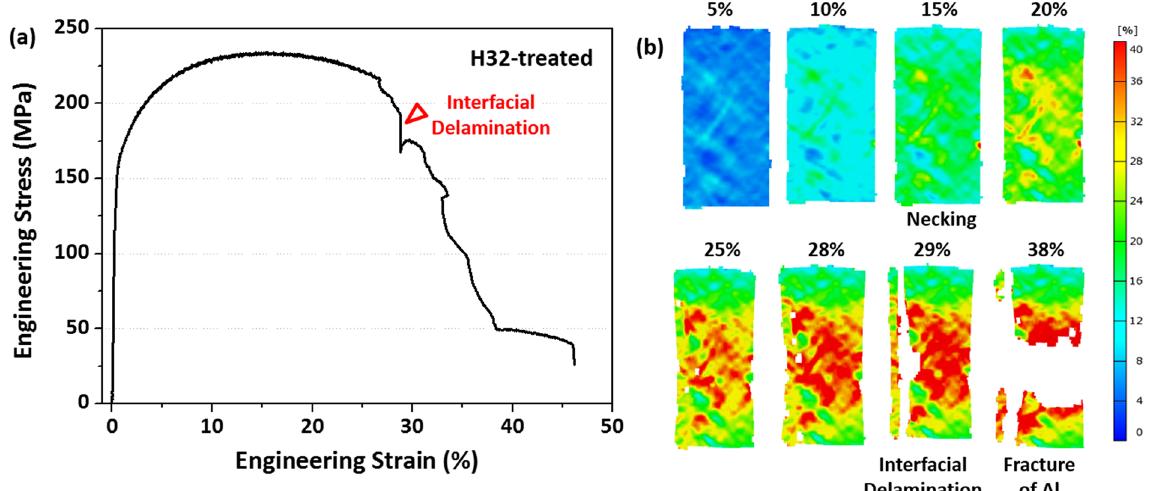
Figure 9. Room-temperature engineering stress-strain curve and digital images of strain distribution of the H32-treated Ti/Al clad sheet. Tensile stress-strain curve and digital image of the Ti/Al clad specimen subjected to H32 treatment of 5052 Al alloy (18.8%-cold-rolling and 400 °C-30-min-annealing). The yield strength, tensile strength, total elongation, and effective elongation (strain at the interfacial delamination point) of the H32- treated clad specimen are 151 MPa, 234 MPa, 38%, and 29%,